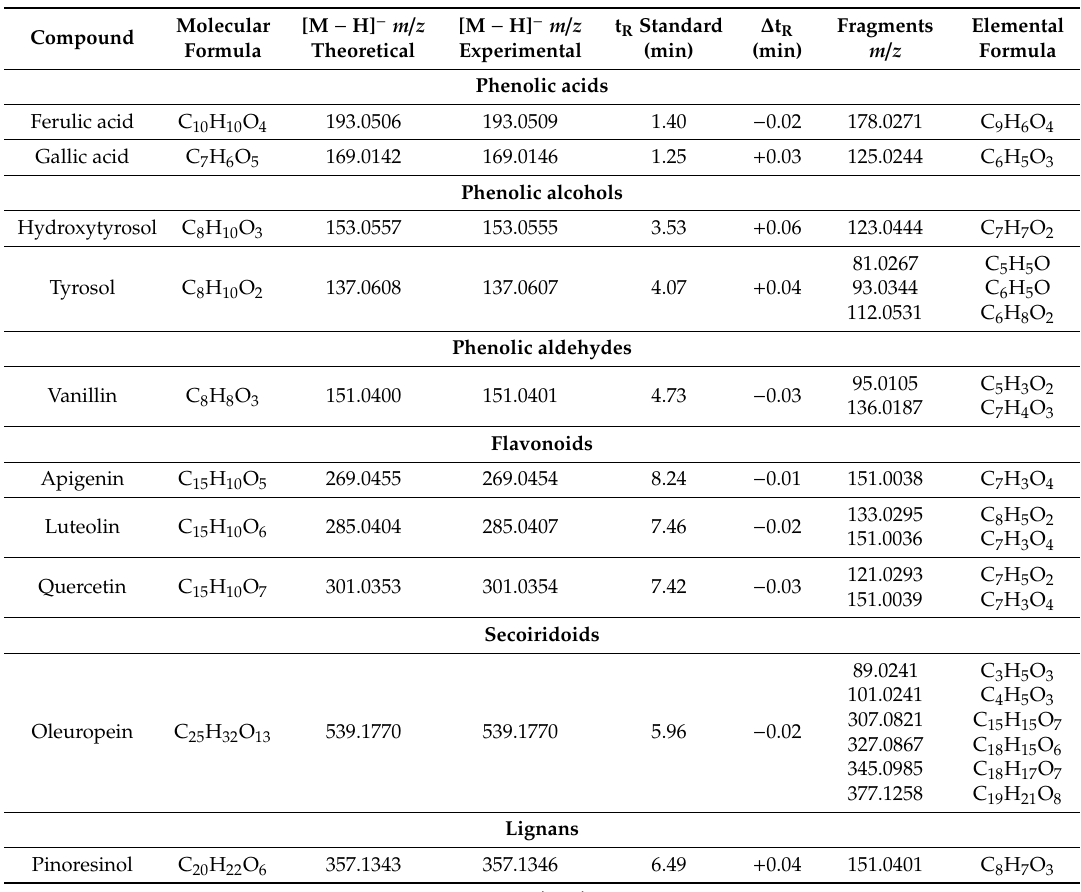
Table 3. Target screening results in leaves.